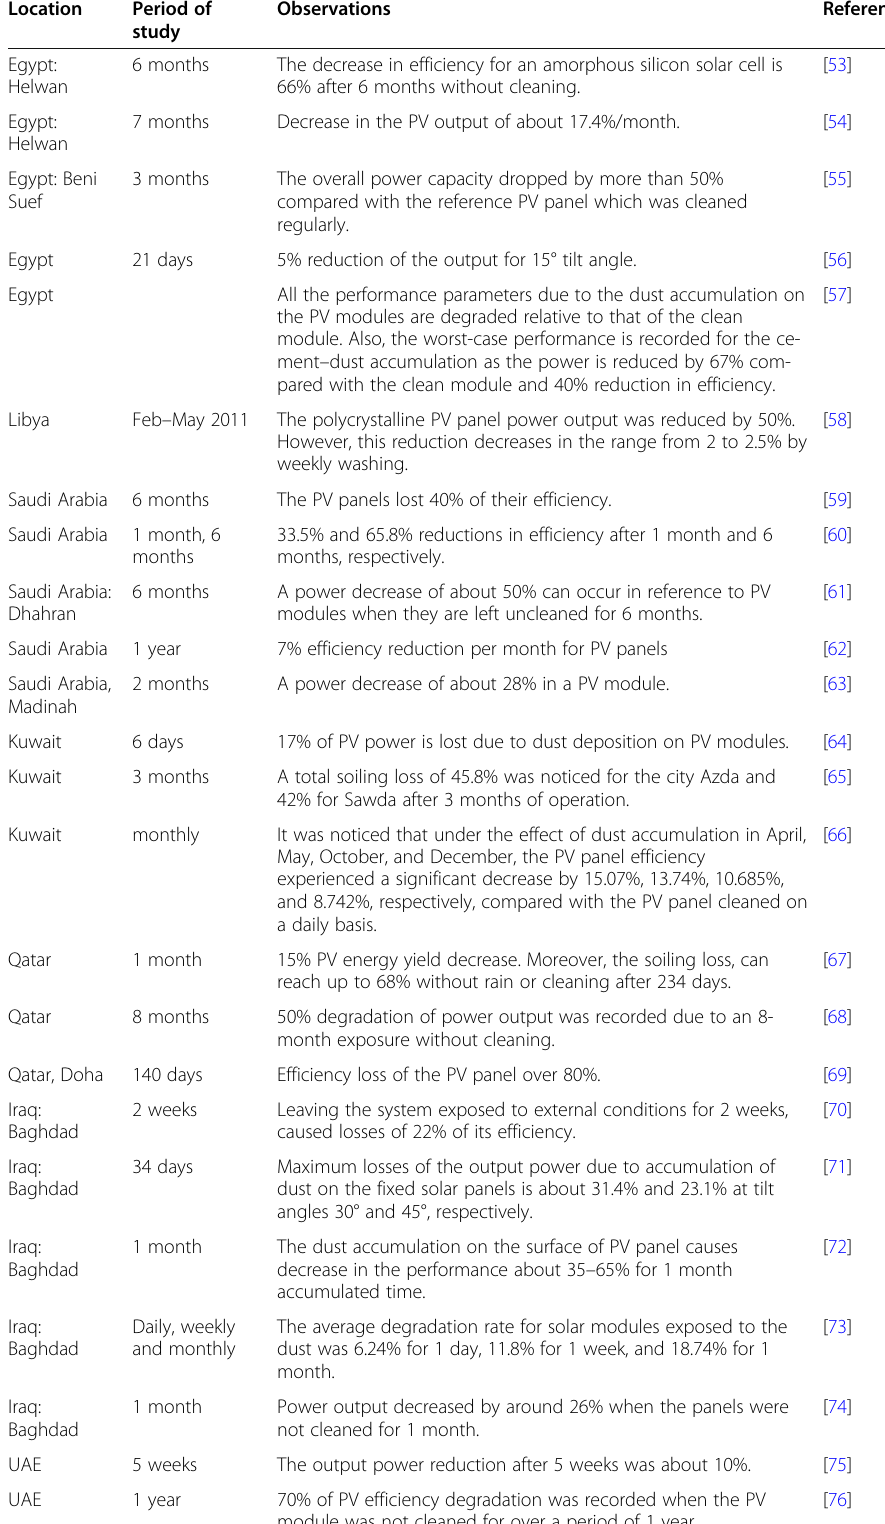
Table 2 Summary of selected reports of dust effects on the performance of PV panels in some countries of the MENA and the Far East regions Location Period of Observations study